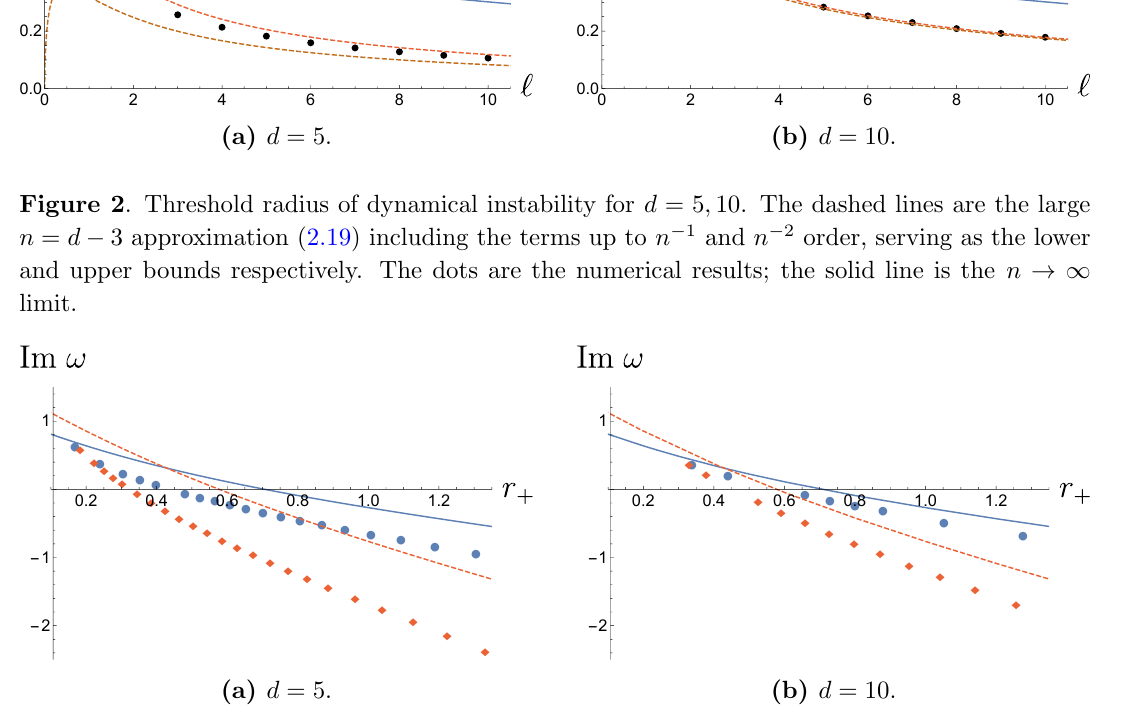
Figure 3 . Dispersion relation for d = 5 ; 10. The solid and dashed lines are the large n approxi- mation (2.22) for ‘ = 1 ; 2, respectively; the circle and diamond dots are the numerical results for ‘ = 1 ; 2, respectively. To make these plots, we replaced ^ ‘ with ‘ in the relation